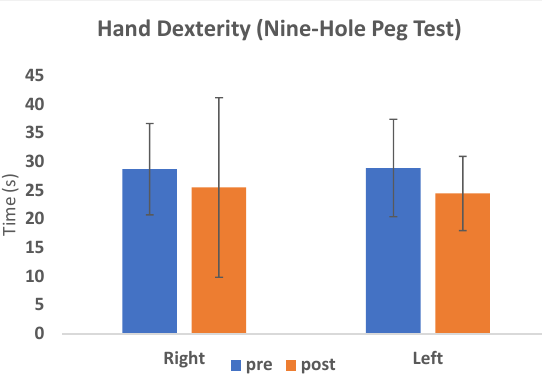
Figure 4. The average values of hand dexterity corresponding to the pre-surgery evaluation are shown in blue, whereas the values of hand dexterity corresponding to the post-surgery evaluation are shown in orange, distinguishing between right and left hand. Significant differences are shown with * ( p < 0.05). Furthermore, the mean values of right hand strength were 26.2 vs. 27.4 kg, while the mean values of left hand strength were 24.4 and 25.7 kg (Table 4); no significant improvement of the postoperative strength was found for both hands ( p = 0.055 and 0.068) (Figure 5).